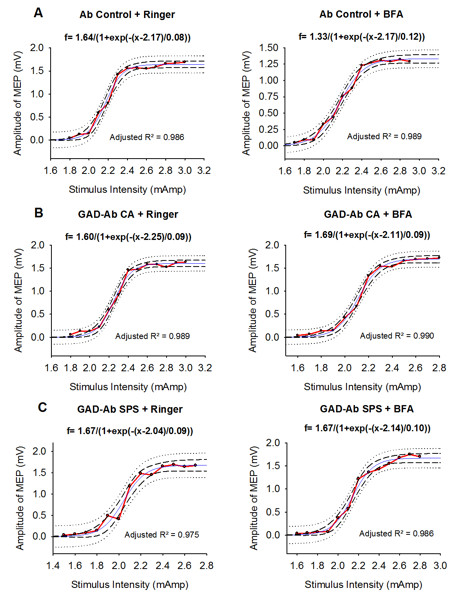
Sigmoidal fitting of recruitment curves of motor evoked potentials (MEP). Upper panels: Ab Ctrl, middle panels: Ab CA, lower panels: Ab SPS. Left panels: Ringer's. Right panels: BFA. Amplitudes are expressed in mV. Dash: 95% prediction band, dotted: 95% confidence band, p < 0.01 for each side. R2 value > 0.970 (p < 0.005).